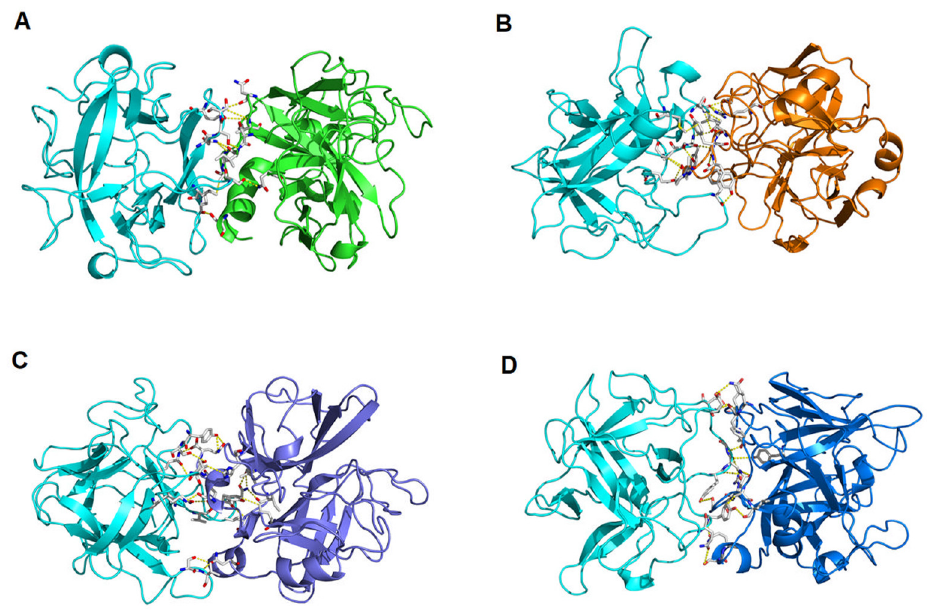
Figure 8. Theoretical three-dimensional model for the talisin / Try 6 ( A ), talisin / Try 12 ( B ), talisin / Chy 6 ( C ) and talisin / Chy 12 ( D ) complexes.